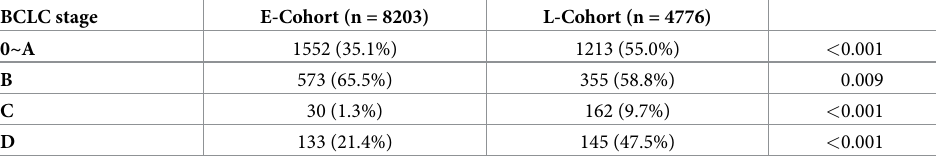
Table 3. Adherence rates of BCLC treatment guideline in each BCLC stage in the E-Cohort and the